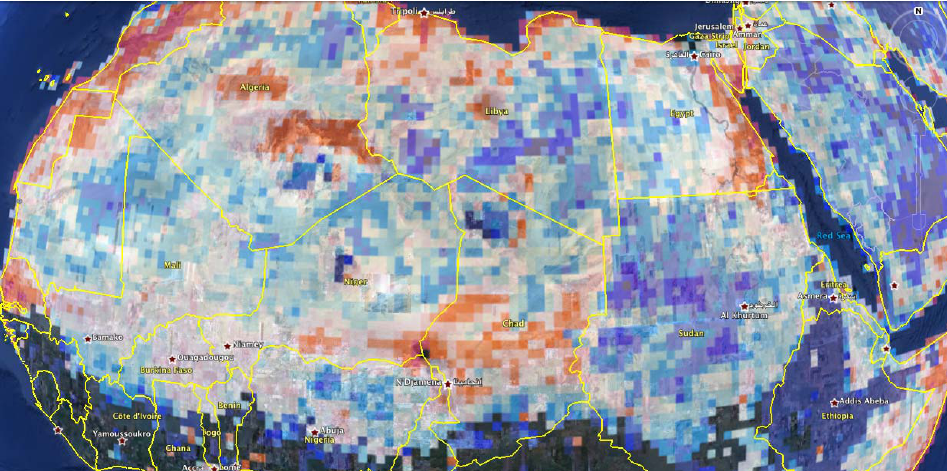
Fig. 6. Overlay of Fig. 3b on Google Earth over North